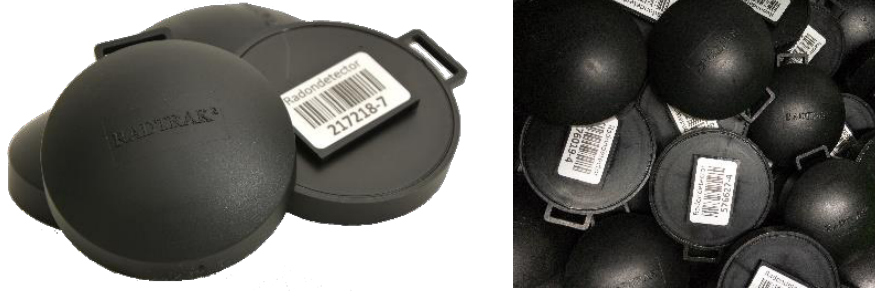
Figure 1. RADTRAK2 detector for measuring concentrations of 222 Rn in homes in long-term—from 2 months to 1 year.